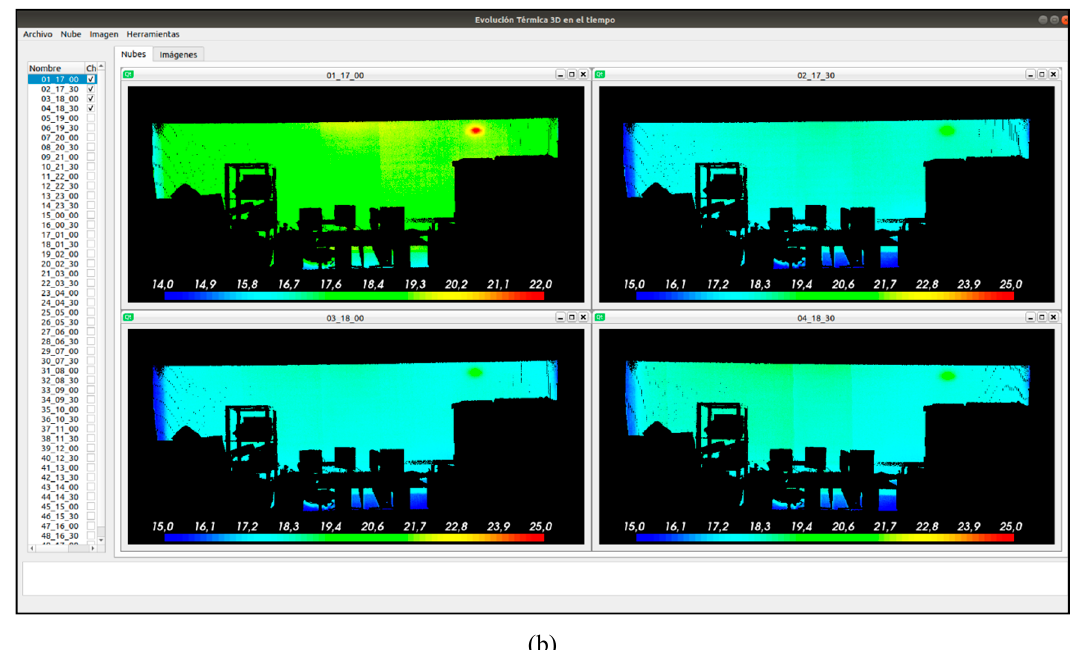
Figure 13. ( a ) Wall used to illustrate the thermal evolution of the Module 2 results. ( b ) Thermal orthoimages for different times.